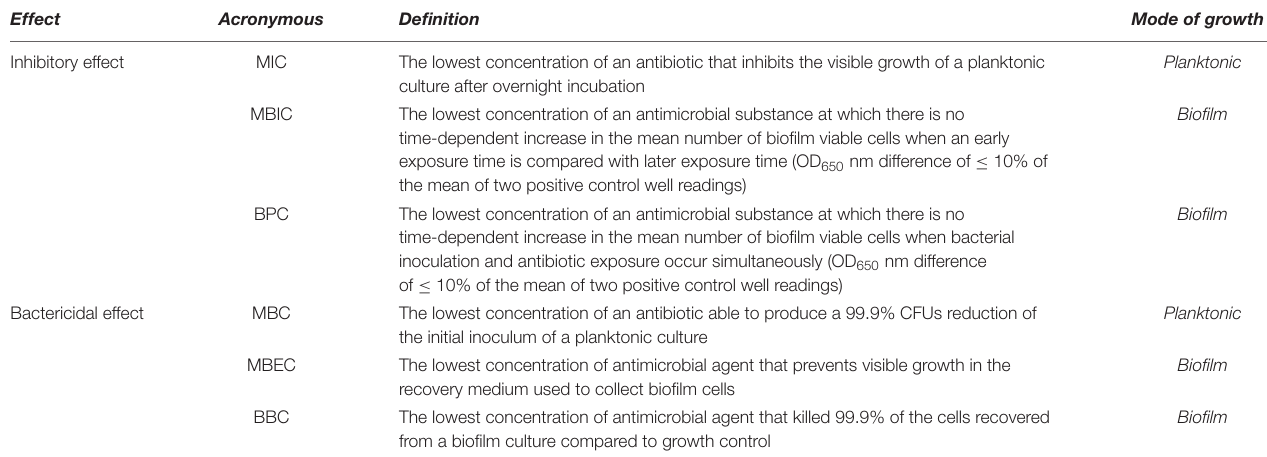
TABLE 1 | Pharmacodynamic parameters employed to analyze the effect of antimicrobial substances, on both planktonic tests and tests accounting biofilm.